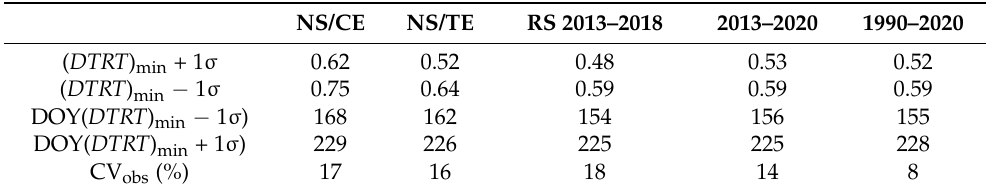
Table 4. Start and end values and timing of DTRT “plateau” in NS/CE orchard, NS/TE crop canopy and at the RS climate